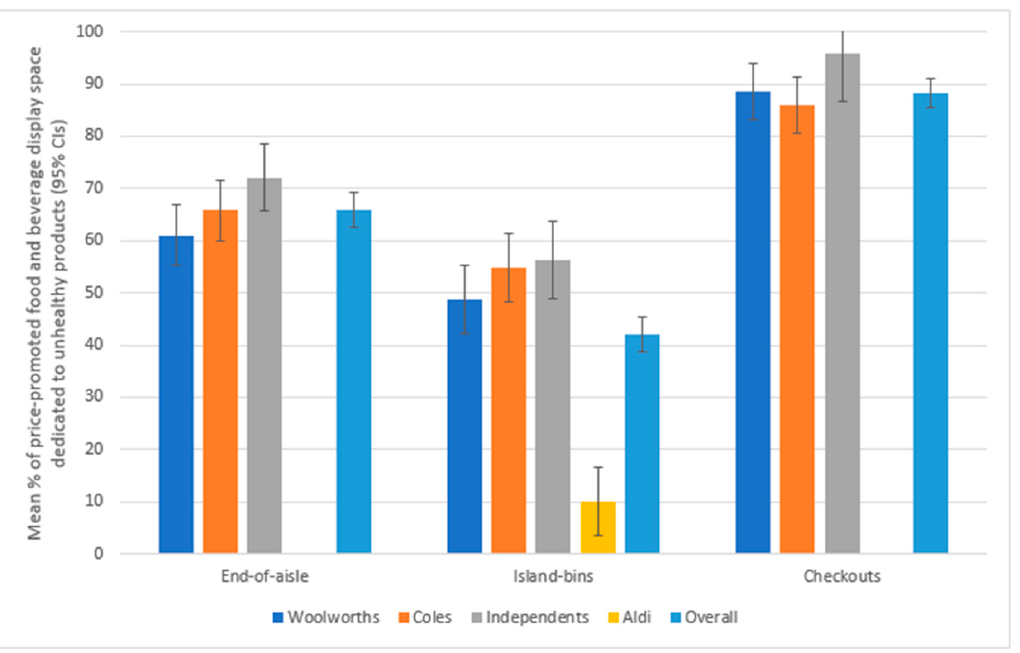
Figure 1. Mean proportion (%) of price-promoted food and beverage display space dedicated to unhealthy products † at each in-store supermarket location, by supermarket group in 2019. Figure depicts results of linear models that included supermarket group, SEP and interaction supermarket group by SEP. Aldi was not included in the linear model or overall mean % for end-of-aisle or checkout displays due to there being insufficient numbers of price promotions in those location. † Foods were classified as healthy based on the Australian Bureau of Statistics Discretionary Food List.